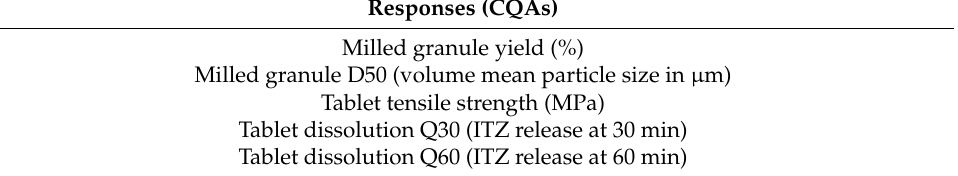
Table 1. Experimental design for studying the effect of independent variables on CQAs of ITZ:HPMCAS ASD extrudates. Independent Variables Type I Type 2 Type 3 Type of Feedstock a HCF PE CRF Low Medium High